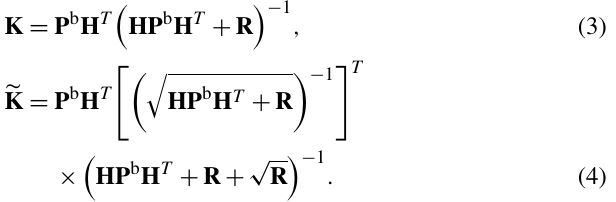
quantity, highest-quality input data set with the least spatial